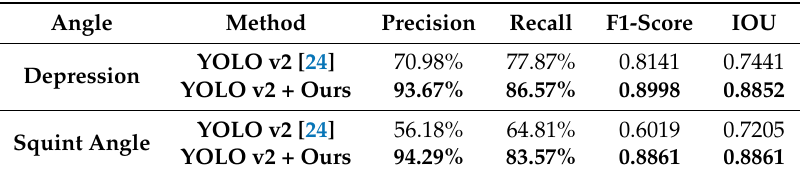
Table 2. Comparison detection performance with YOLO v2.